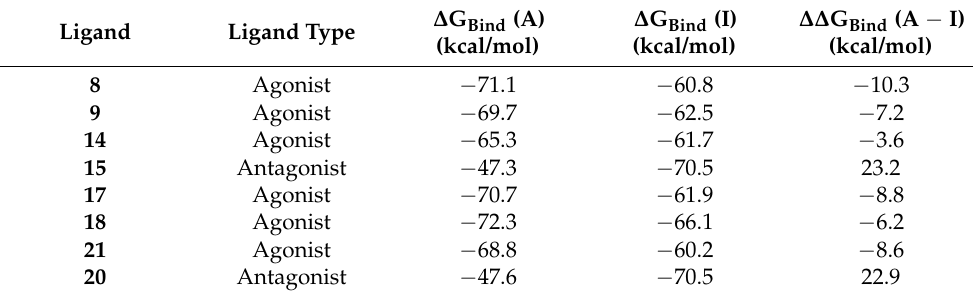
Table 4. MM/GBSA calculations for C9-substituted